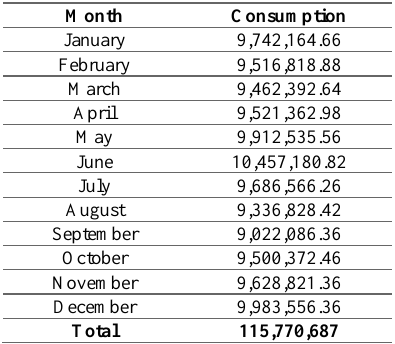
Table 3. Consumption data per month resulted from forecast